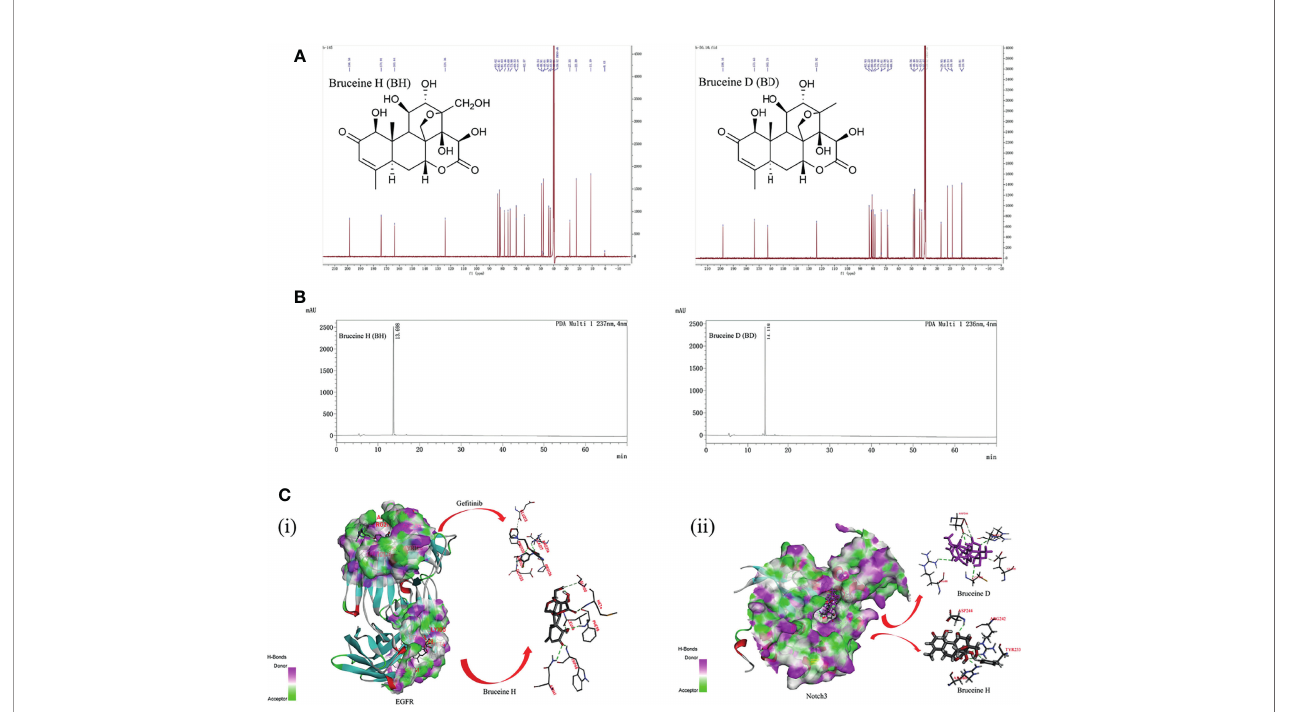
FIGURE 1 | The interaction of bruceine H (BH) with Notch3 and epidermal growth factor receptor (EGFR) proteins. (A) Chemical structure of BH and bruceine D (BD) by 13 C NMR spectrum. (B) The purity of BH and BD by HPLC chromatogram. (C) Computational modeling of BH binding to Notch3 and EGFR. (i) 3D interaction of BH and ge fi tinib with the EGFR protein. (ii) 3D interaction of BH and BD with the Notch3